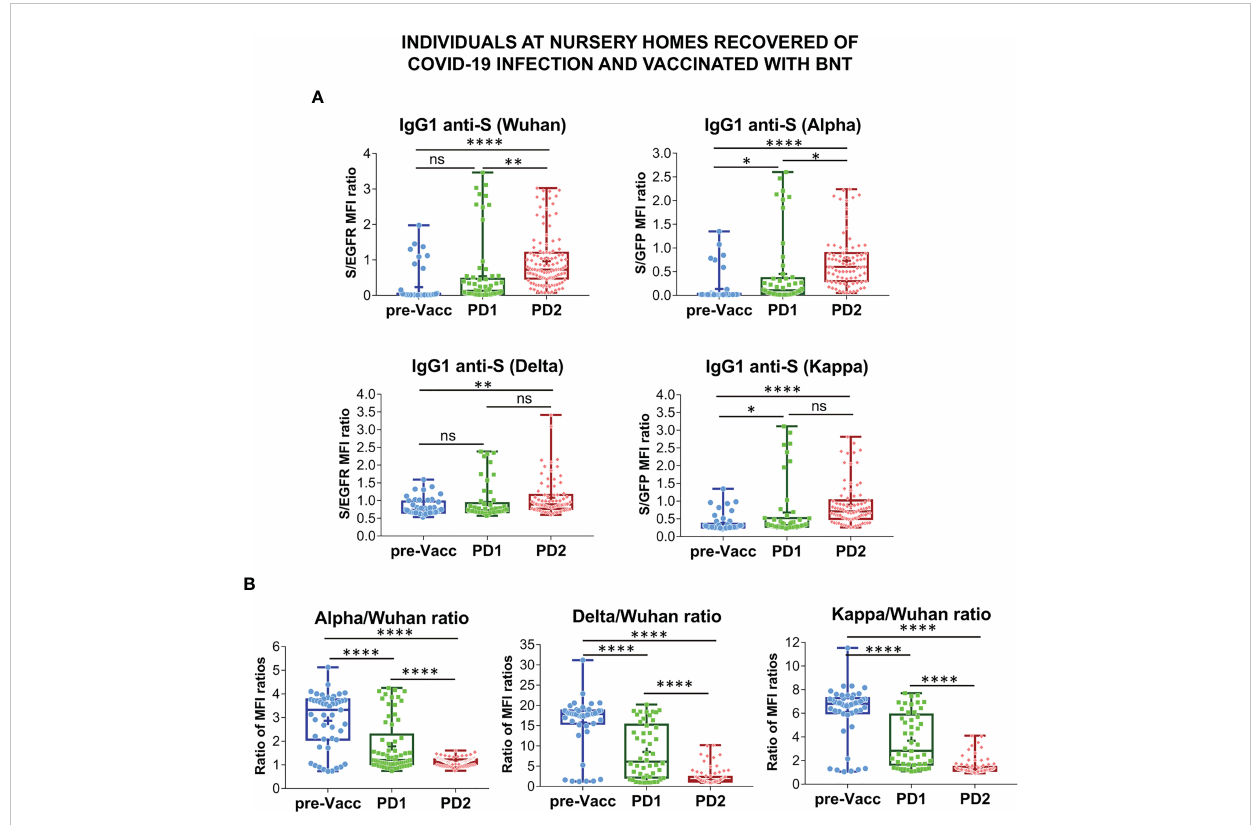
FIGURE 4 Follow-up of the antibody response to vaccination in nursing homes. (A) Generation of antibodies against the S protein of the Wuhan, Alpha, Delta and Kappa variants before (pre-Vacc) and after vaccination with the fi rst dose (PD1) and the second dose (PD2) of BNT/P fi zer. The normalized S/ EGFR ratio for reactivity with the Wuhan and Delta variants, and the S/GFP ratio for reactivity with the Alpha and Kappa variants was measured as a quantitative calculation of IgG1 anti-S antibody content. Sera were all used at a 1:50 dilution. Box and whiskers plots to represent minimum and maximum values as well as the median, and the mean (the mean with a cross) are shown. * p <0.05; ** p <0.01; **** p <0.0001 (one-way ANOVA test). (B) Relative reactivity of the sera tested in (A) against the Alpha, Delta and Kappa variants versus the Wuhan strain was calculated according to the ratio of S/EGFR or S/GFP ratios and plotted individually for each serum donor. **** p <0.0001 (one-way ANOVA test). “ NS ” means "not signi fi cant" in the context of statistical